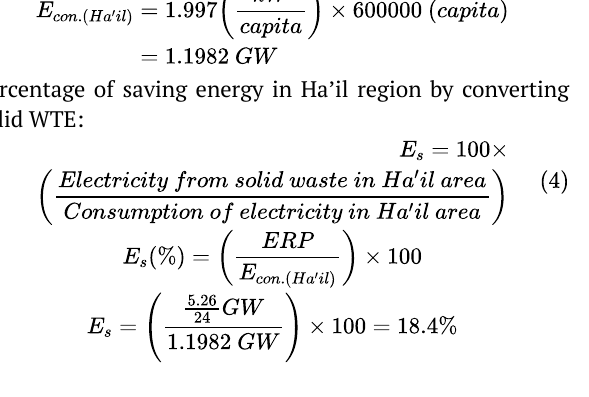
Table III. Results of Energy Recovery Potential (ERP) Type of